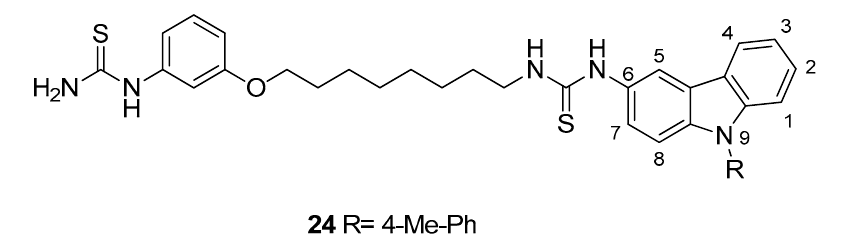
Figure 10. Structure of arylthiourea-carbazole derivative ( 24 ).